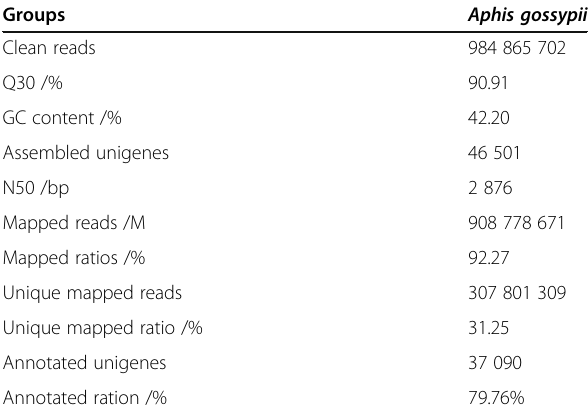
Table 1 Summary of transcriptome data of cotton aphid Groups Aphis